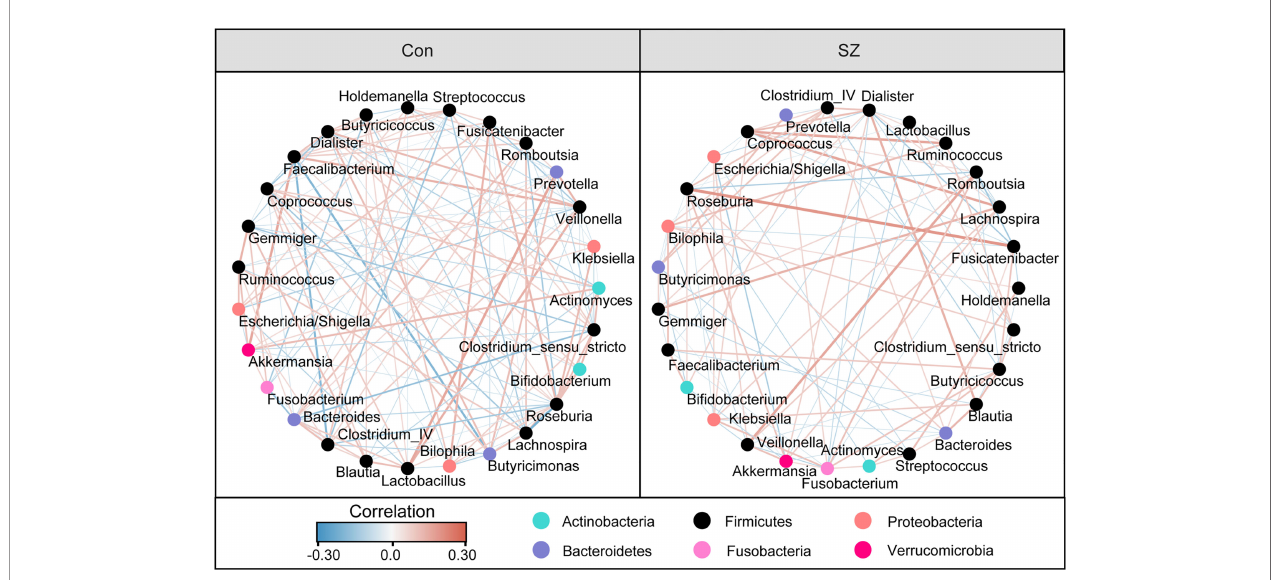
FIGURE 3 | Strengths of the correlation between abundant fecal microbiota in the elderly SZ patients and the healthy controls. Correlation network of the abundant fecal microbiota in the healthy controls and the elderly SZ patients. The correlation coef fi cients were calculated with the Sparse Correlations for Compositional (SparCC) data algorithm. Cytoscape version 3.4.0 was used for network construction. The red and blue lines represent positive and negative correlations, respectively. The correlation network became simpler in the elderly SZ